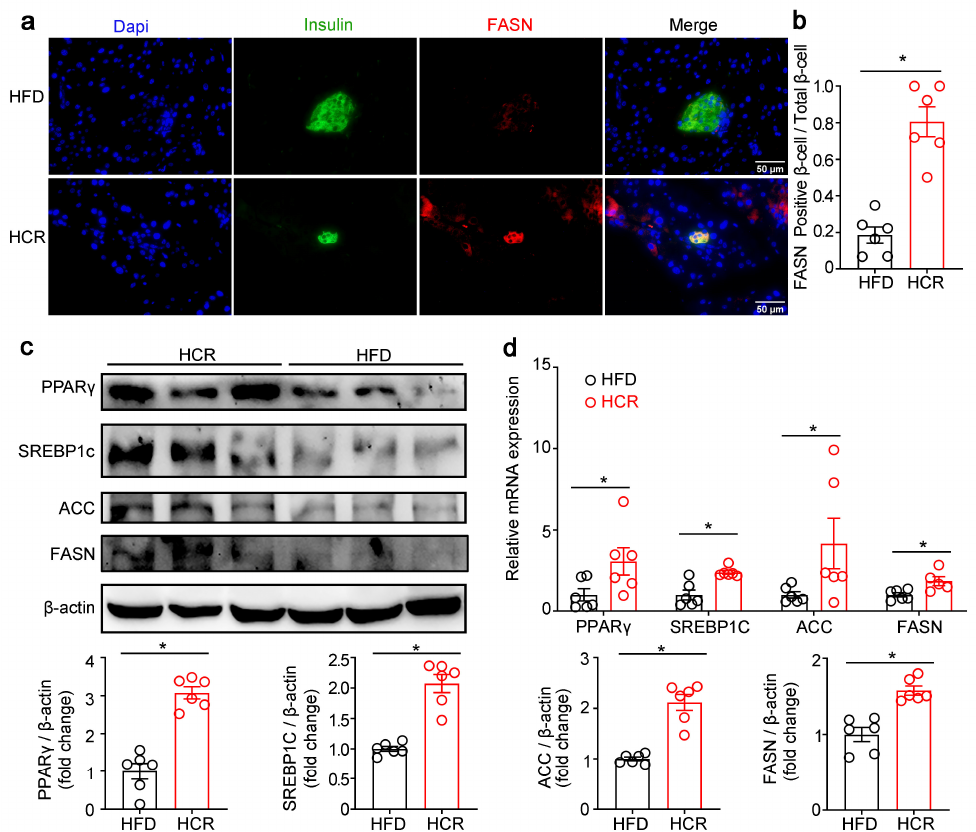
Figure 6. CR stimulated the lipogenic gene expression in pancreas of high-fat diet-fed mice. ( a ) Representative immunofluorescence images of fatty acid synthase (FASN, red) and insulin (green). ( b ) Quantification of FASN-positive β -cells/total β -cells. ( c ) Representative Western blot from HFD or HCR mouse pancreas. PPAR γ , SREBP1c, ACC, and FASN were measured. Quantification of PPAR γ , SREBP1c, ACC, and FASN. ( d ) PPAR γ , SREBP1c, ACC, and FASN mRNA levels. The results were expressed as mean values ± SEM. (six mice per group), * p < 0.05 vs. HFD mice.